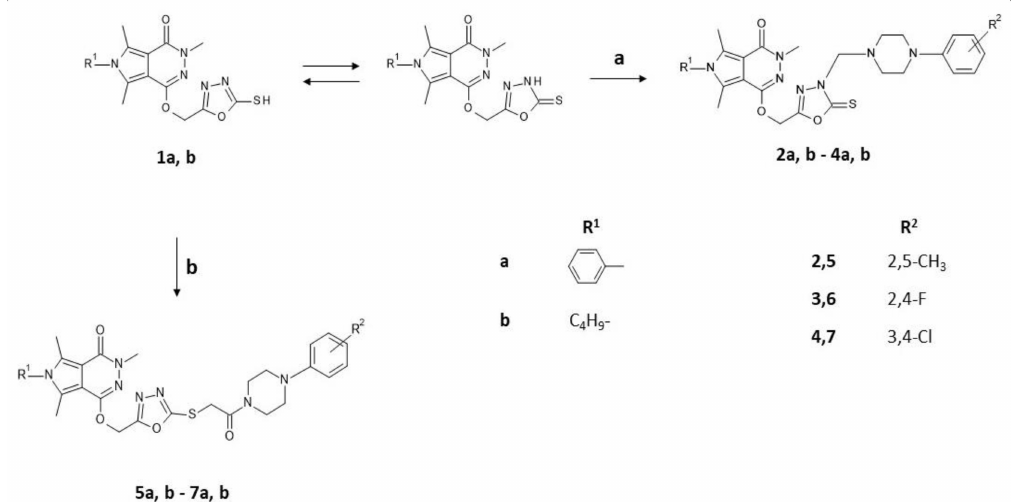
Scheme 1. Synthesis and structures of final compounds 2a, b–7a, b . Reagents and conditions: ( a ) C 2 H 5 OH, 37% HCHO, arylpiperazine, RT, stirring 5 h; ( b ) C 2 H 5 OH, C 2 H 5 ONa, 1-(2-chloro-1-oxoethyl) 4-arylpiperazine, reflux 5